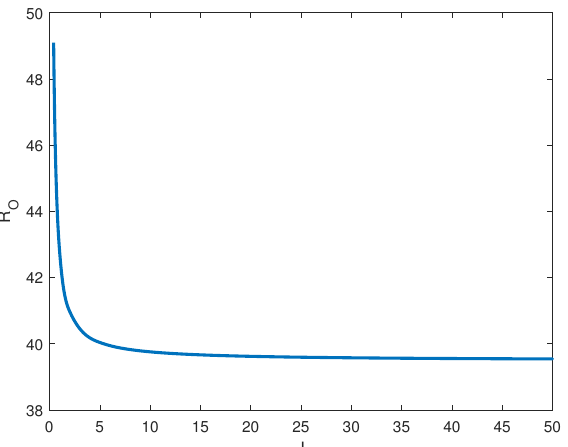
Figure 1. Asymptotic behaviour of R O with respect to J for { γ = 0.8; k r = 1.5, η = 0.2, T 2 = 10 } .